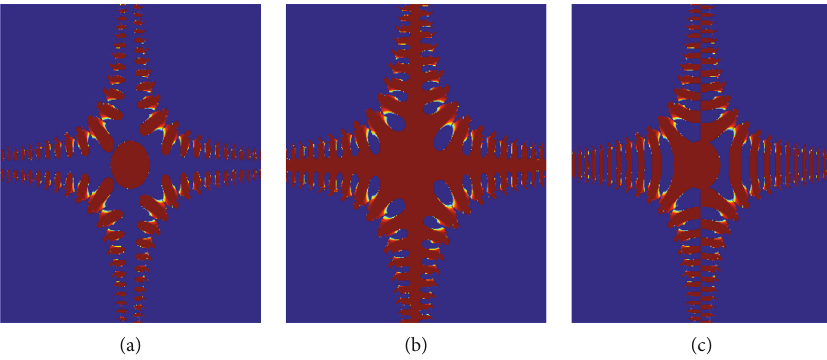
Figure 9: E ff ect of change in sign as well change in real to complex parameter a on quadratic Mandelbrot set. Table 8: Parameters for generation of quadratic Mandelbrot set for di ff erent values of a .